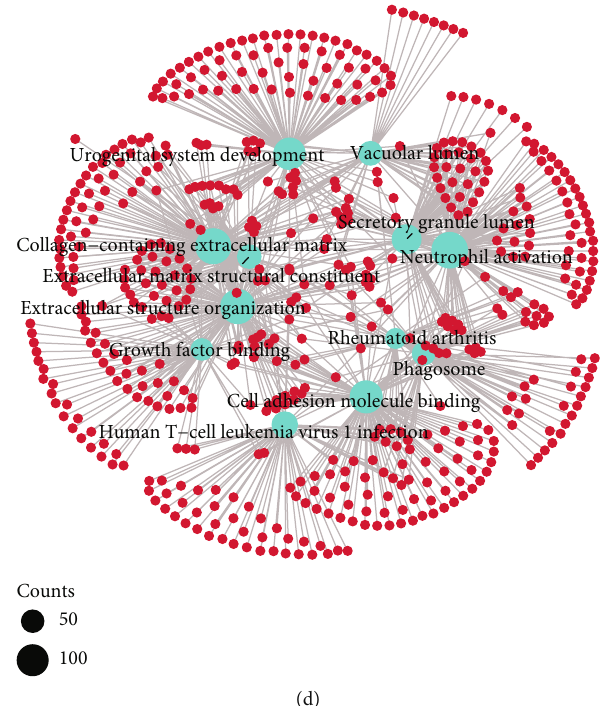
Figure 1: (a) Volcano plot: the fold change and P adjusted values were used in the construction of the volcano plot. (b) Principal component analysis of the samples. (c) The pop plot of enrichment analysis of di ff erentially expressed genes. (d) Network of enrichment